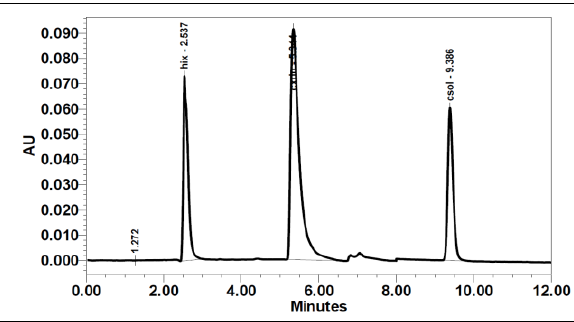
Fig. 2 . HPLC chromatogram of the pure drugs showing simultaneous separation of HEX, CHX & CSOL (10.00 µg/mL each) at a timed wavelength of 265, 260 & 230 nm; respectively.